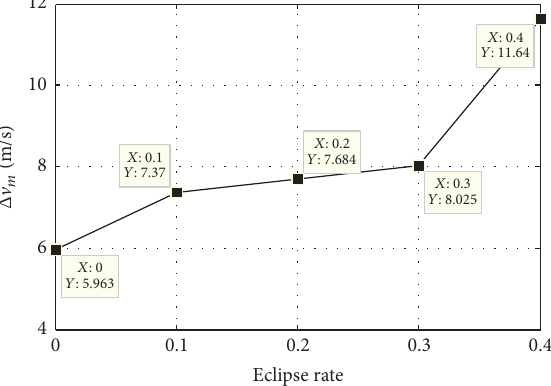
Figure 5: Eclipse rate influence on mean fuel consumption.